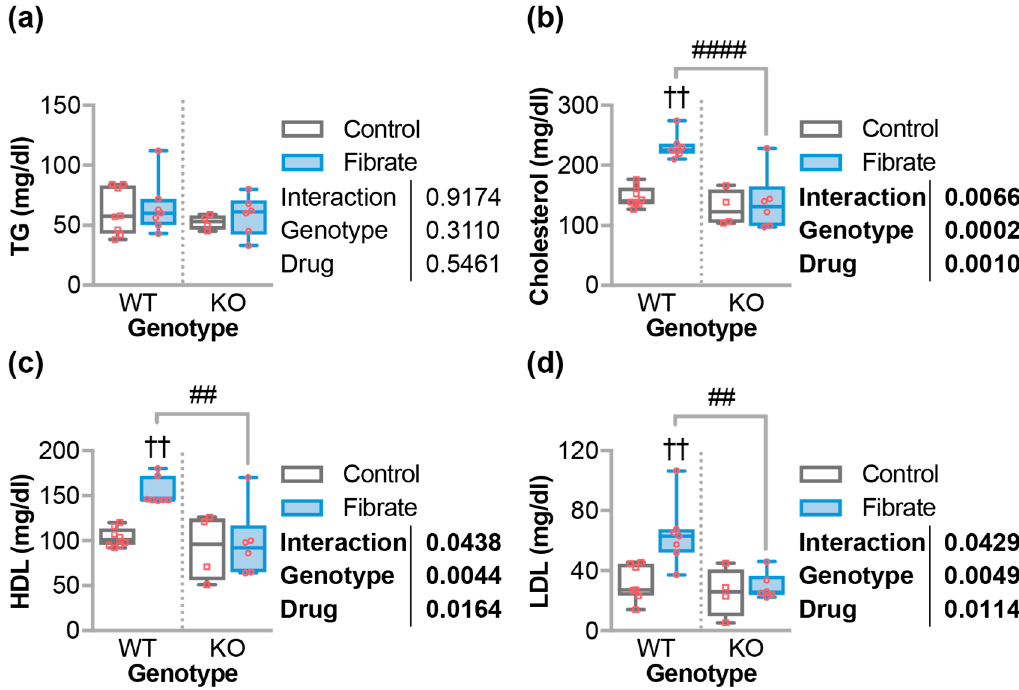
Figure 3. Fenofibrate effects on circulating lipid levels. ( a ) Triglycerides (TG), ( b ) total cholesterol, ( c ) HDL cholesterol, and ( d ) LDL cholesterol in either wild-type (WT) or CHIP − / − (KO) mice fed control or fenofibrate chow, which is represented by a boxplot with biological replicates plotted. Results of two-way ANOVA are provided. Tukey’s post-test: †† indicate p < 0.01 comparing control vs. fibrate conditions. ## and #### indicate p < 0.01 and 0.0001 comparing WT vs. KO conditions.